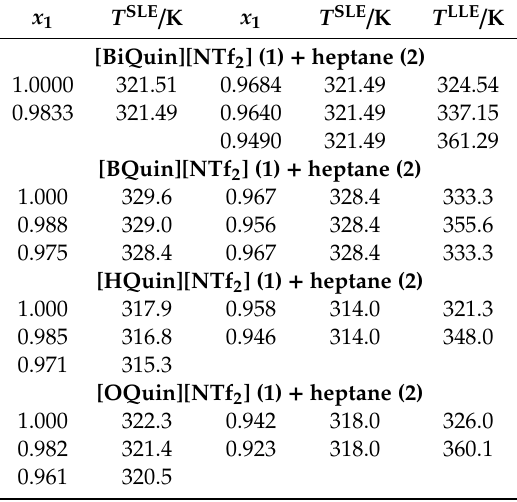
Table 4. Experimental (solid + liquid) phase equilibrium data, SLE, for {IL (1) + heptane (2)} binary systems at pressure p = 0.1 MPa: x 1 is the ionic liquid mole fraction; T SLE is the equilibrium temperature a,b . x 1 T SLE /